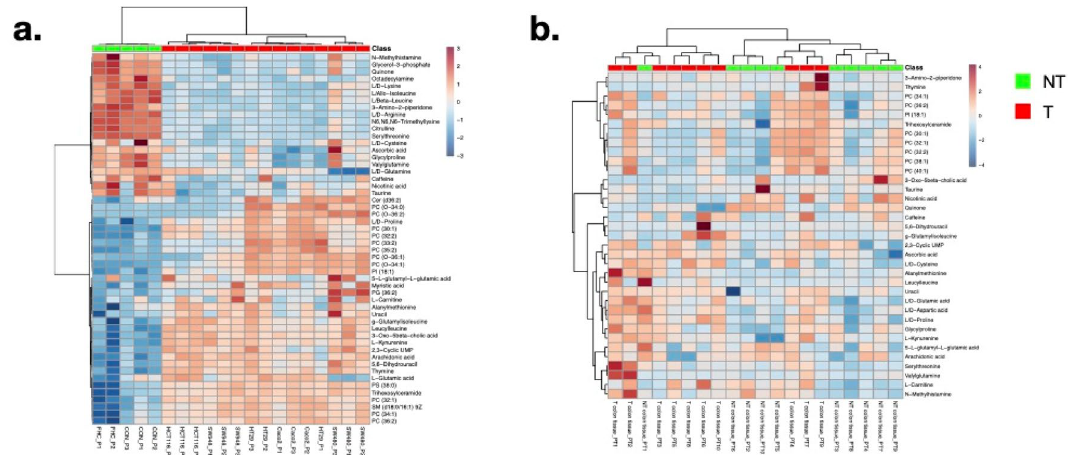
Figure 1. Heat map of metabolites that discriminate between the non-transformed and transformed state in ( a ) colon cell lines and ( b ) colon tissue. Normalization was performed by dividing the peak area (expressed by arbitrary units) of a specific component in a sample by the mean peak area of that component in the next two QC samples that were run after every ten samples. Hierarchical clustering was performed using Pearson correlation coefficient and Ward linkage. P1-3 = cell line passage 1–3 (1-week time interval, considered as replicate); PT1-10 = colorectal cancer patient